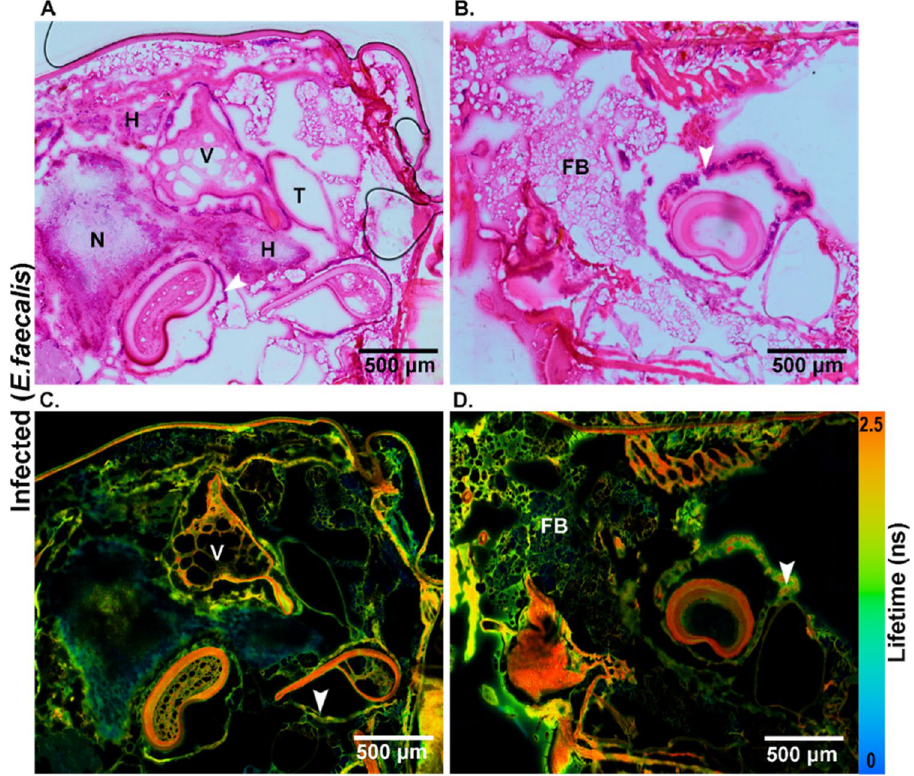
Figure 3. Visualization of the transverse section of E. faecalis infected tissue from G. mellonella larvae. ( A , B ) HE stained images and ( C , D ) FLIM images illustrate endogenous fluorophores such as flavins and lipo- pigments with different lifetime information as false-color images ranging from blue to red (scale 0–2.5 ns). V = vacuolization, N = nodules, FB = fat body, H = hemocytes, T = trachea. White arrowheads indicate the dissociation of the tissue around tubular organs or silk glands.